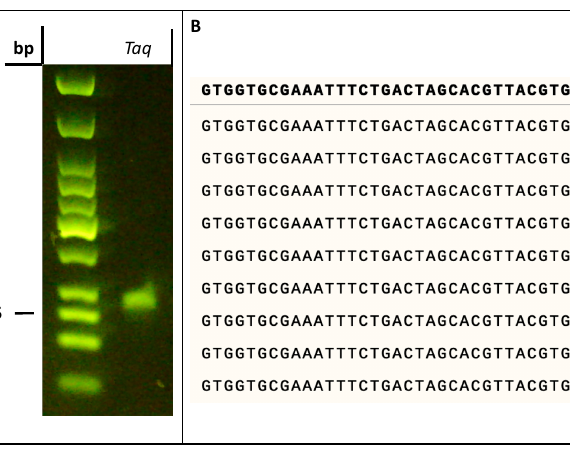
Figure 7. ( A ) Gel image (agarose 2%) analysis showing the product of the conversion of dU Van -modified dsDNA into natural dsDNA by means of PCR in presence of Taq as a polymerase. The reaction was performed in 25 µL and contained purified dU Van -modified dsDNA (10 nM), primers P3 / P4 (500 nM), dNTPs (200 µM), Mg 2+ (2 mM), Thermopol buffer (2.5 µL of 10X) and Taq (5U, 1 µL). The PCR program was 95 °C for 5 min, (95 °C 30 ′ ’, 52 °C 30 ′ ’, 75 °C 30 ′ ’) X 10 cycles, and a final elongation at 75 °C for 5 min. ( B ) Sequence alignment of nine different plasmid colonies obtained by PCR conversion of dU Van -modified dsDNA to natural DNA followed by cloning and sequencing. The first line in bold corresponds to the sequence of template T2 , while the following nine lines correspond to the sequenced products.